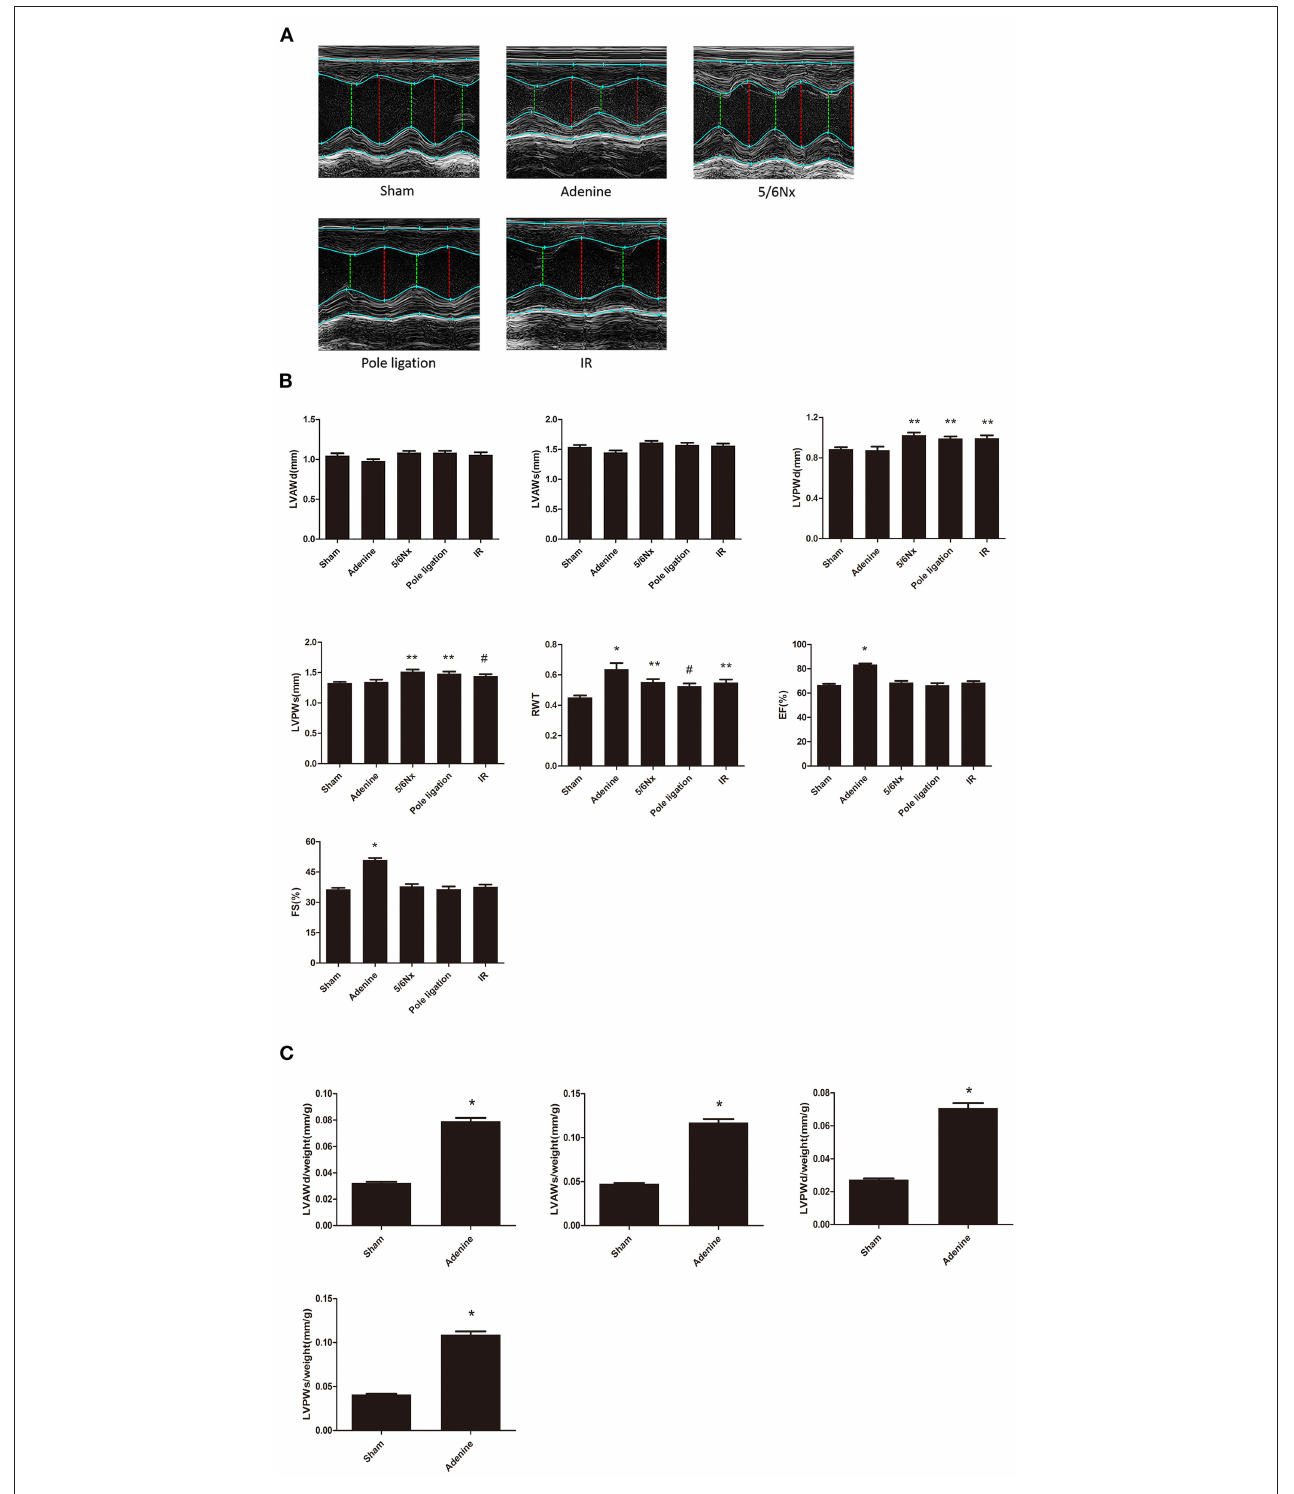
FIGURE 4 | Between-group comparisons of cardiac characteristics in echocardiography. (A) Representative M-mode echocardiograms from the sham, adenine group, 5/6th nephrectomy group (5/6Nx), pole ligation group, and uninephrectomy plus contralateral ischemia followed by reperfusion group (IR); (B) The mean LVAWS, LVPWs, LVPWs, LVPWd, RWT, LVEF, and LVFS in the five groups. Data are presented as the mean ± SEM ( n = 14–22). (C) The mean LVAWs/BW, LVPWs/BW, LVPWs/BW, and LVPWd/BW in the sham and adenine groups. Data are presented as the mean ± SEM ( n = 14–15). * P < 0.001, vs. Sham; ** P < 0.01, vs. Sham; # P < 0.05, vs.